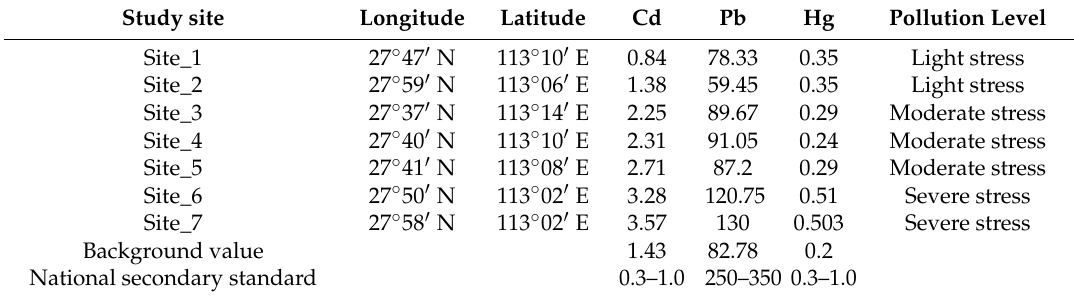
Table 1. Heavy metal content of soil samples in seven sites of study area (mg · kg -1